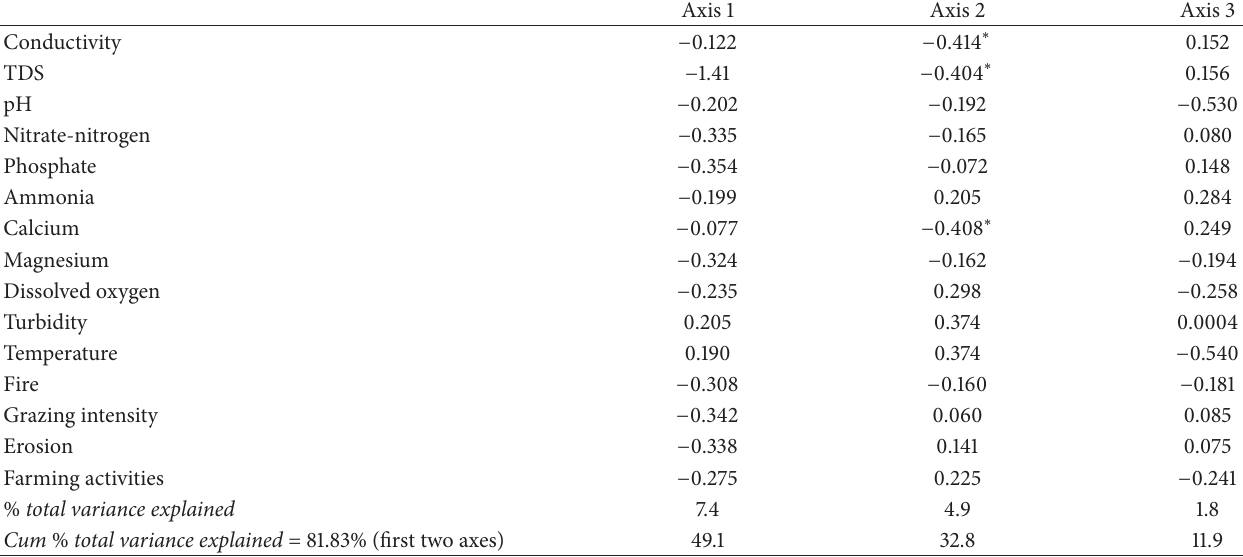
Table 3: Summary of PCA eigenvectors showing the levels of correlation with the first three axes of the environmental variables of the six sites. Asterisks ( ∗ ) indicate significance ( 𝑝 < 0.05 ), following Monte Carlo permutation procedures. Axis 1 Axis